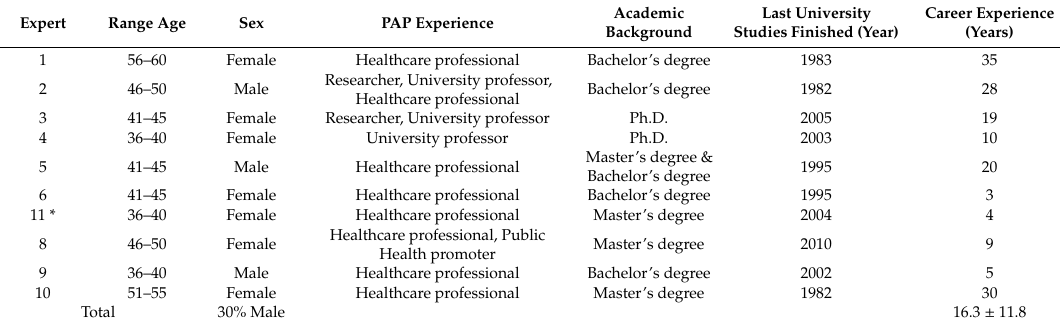
Table 3. Descriptive data of nurses’ experts in physical activity on prescription (PAP).